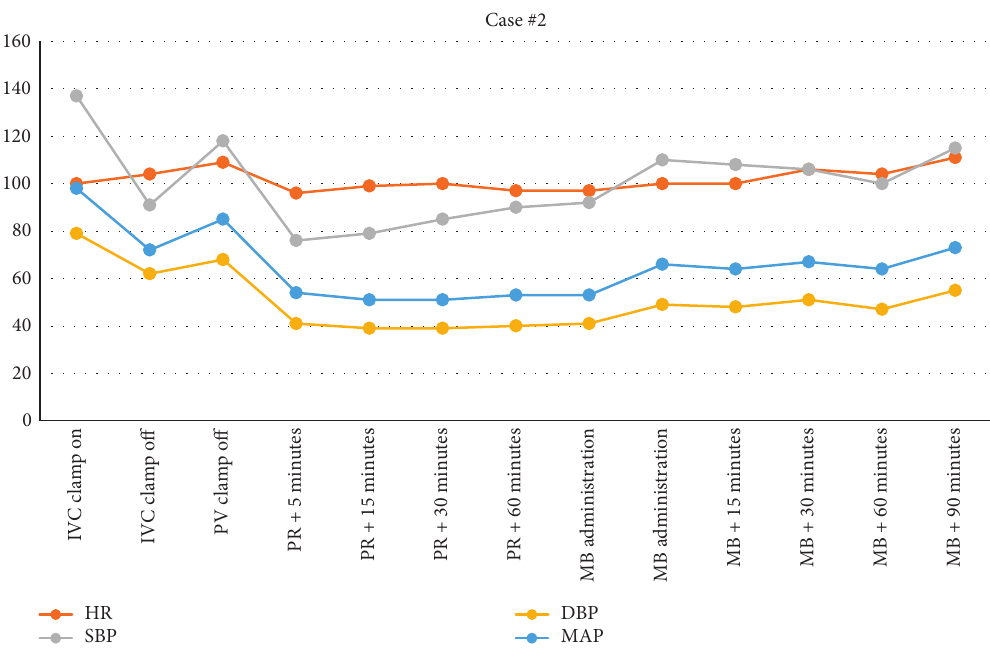
Figure 3: Vital signs from IVC clamp until 90 minutes following MB administration.